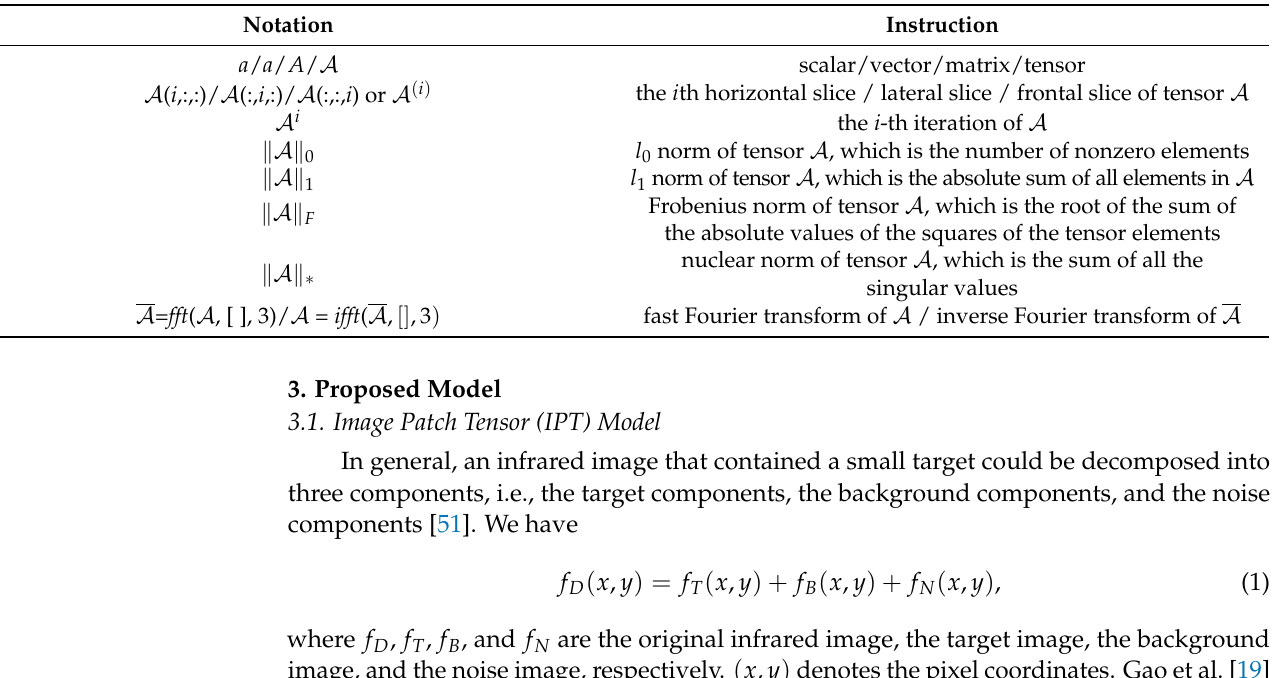
Table 1. Mathematical